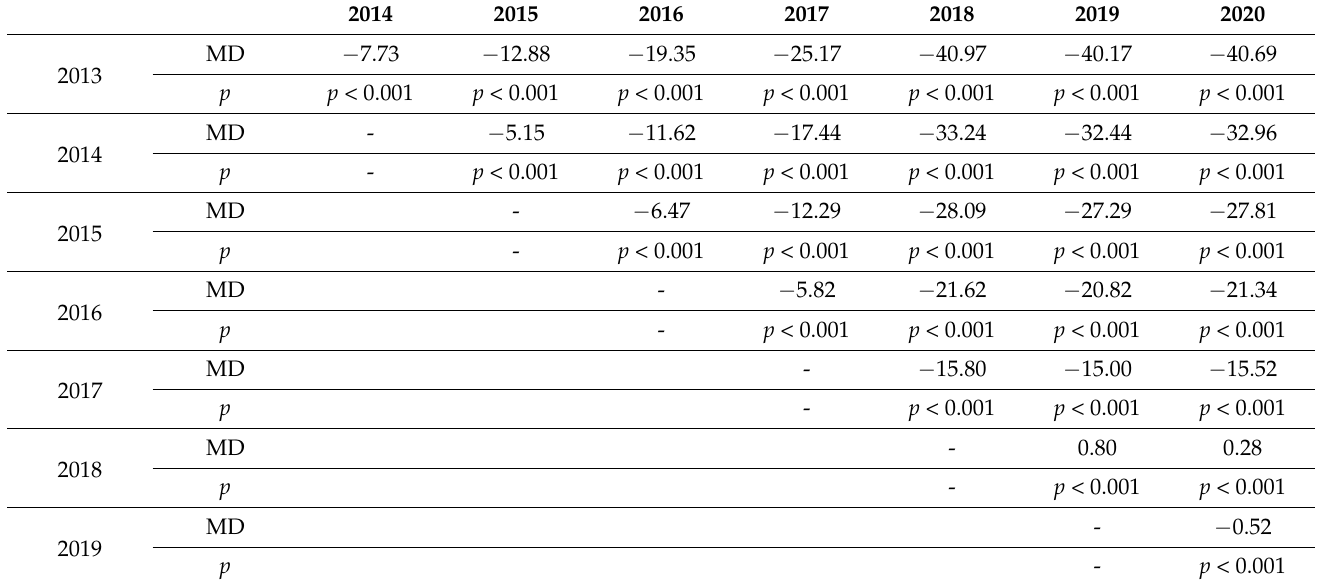
Table 13. Comparison of the use of capnography between individual editions of the